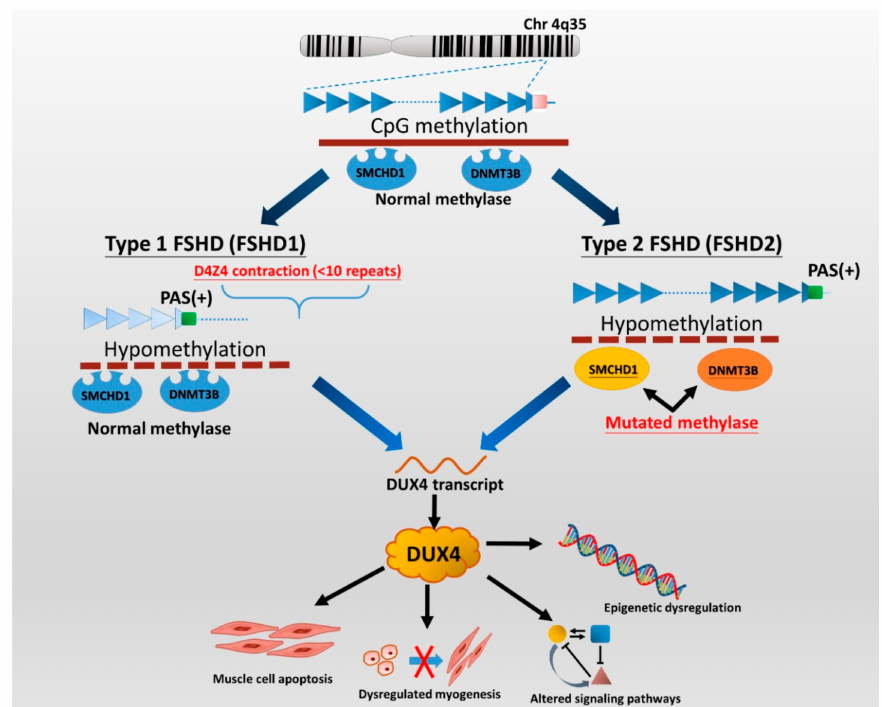
Figure 1. The genetic pathomechanisms of FSHD types 1 and 2. Normal individuals have 11 to more than 100 repeats (50–300 kb) of D4Z4 repeats on the sub-telomeric region of chromosome 4q35, whereas individuals with FSHD1 have a deletion of the array to 10 or fewer D4Z4 units ( < 39 kb). Contraction of D4Z4 repeats with the presence of a permissive 4qA haplotype or allele containing a polyadenylation signal (PAS, green box) then disrupts CpG methylation (hypomethylation), leading to chromatin relaxation at the array and allowing for the expression of a toxic transcription factor, DUX4 (double homeobox 4). Additionally, the DUX4 retrogene within the D4Z4 unit lacks a stabilizing PAS but can use an additional exon immediately distal to the repeat that contains a polyadenylation signal (DUX4-PAS). In FSHD2, mutation of methylase-related genes, SMCHD1 or DNMT3B, also causes hypomethylation of D4Z4 chromatin structure, resulting in DUX4 expression. There are several potential mechanisms of DUX4 involving in FSHD pathogenies. DUX4 has been implicated as being involved in apoptosis, myogenesis, epigenetic regulation, and regulatory signaling pathways in skeletal muscle and extramuscular tissues, including retinal vessels (Wnt / β -catenin pathway) and auditory cells (JNK pathway) [5,6,11]. Picture modified from Lek et al. 2015 [2] and Lim et al. 2020